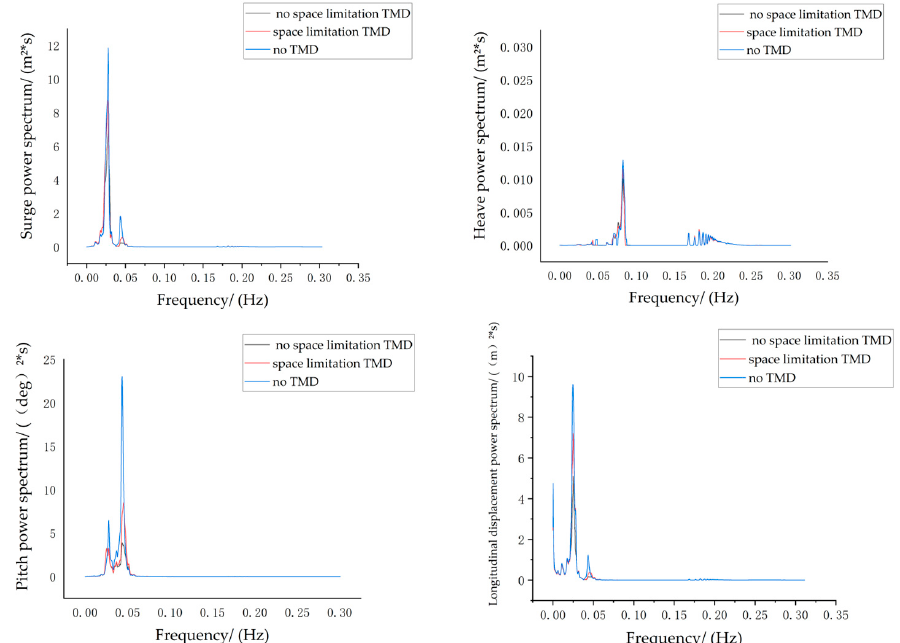
Figure 15. Comparison of FOWT responses in frequency domain under normal operating condi- tions.